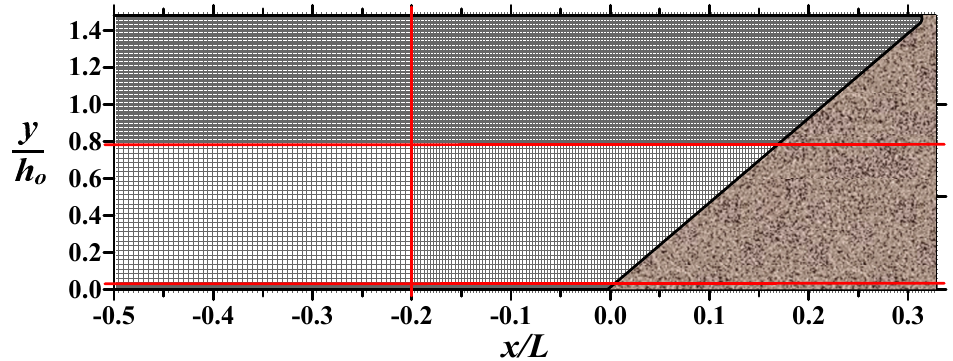
Figure 6. Mesh arrangements for the numerical wave tank. To verify the accuracy of the proposed numerical scheme, the incident periodic wave in this numerical wave flume was compared with the theoretical solutions. Figure 7 shows a comparison between the periodic wave forms generated from the numerical results and the theoretical solutions. The black circles ( ) and solid red line (-) correspond to the (cid:35)